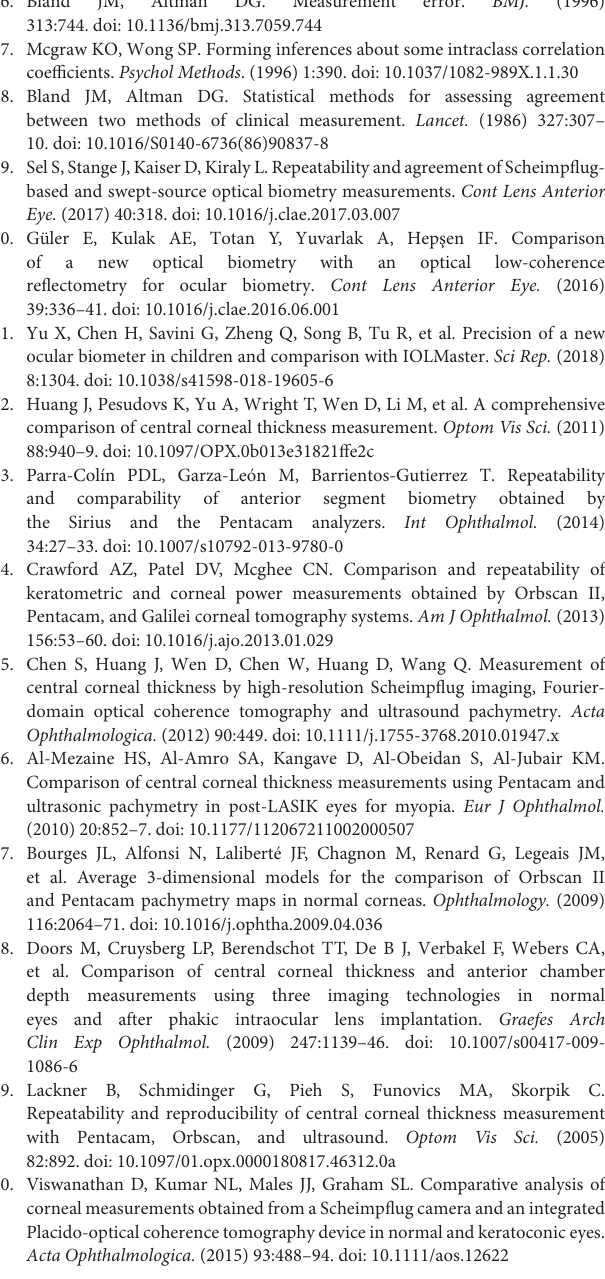
Supplementary Figure 2 | Bland-Altman plots showing the agreement between the new Scheimpflug imager in combination with partial coherence interferometry biometer and the swept-source optical coherence tomography-based biometer for measuring J 45 . Solid lines represent the bias between the two devices and dotted lines represent the 95% confidence interval for the difference. Supplementary Figure 3 | Bland-Altman plots showing the agreement between the new Scheimpflug imager in combination with partial coherence interferometry biometer and the swept-source optical coherence tomography-based biometer for measuring corneal diameter. Solid lines represent the bias between the two devices and dotted lines represent the 95% confidence interval for the